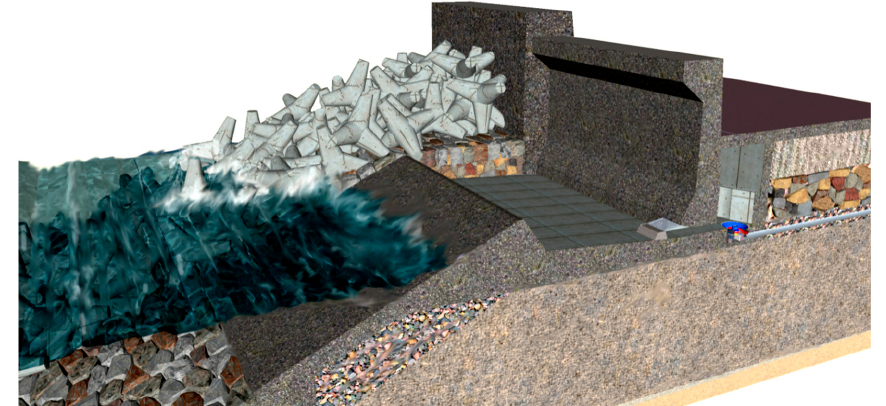
Figure 1. A 3-D rendering of a traditional rubble-mound breakwater and the Overtopping Breakwater for the Energy Conversion (OBREC).